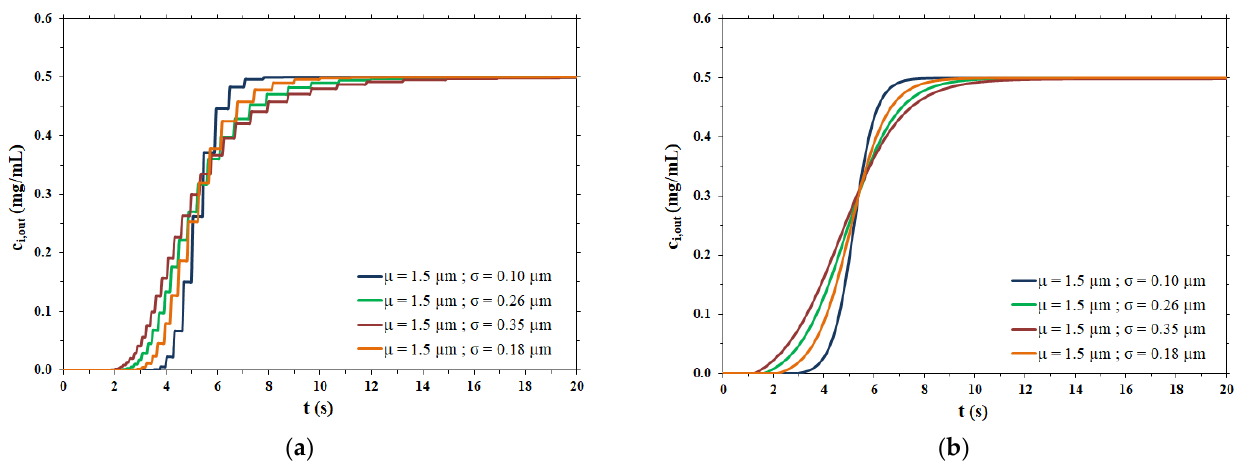
Figure 4. ( a ) Breakthrough curves as a function of the pore size distribution; ( b ) fitting of breakthrough curves as function of the pore size distribution.